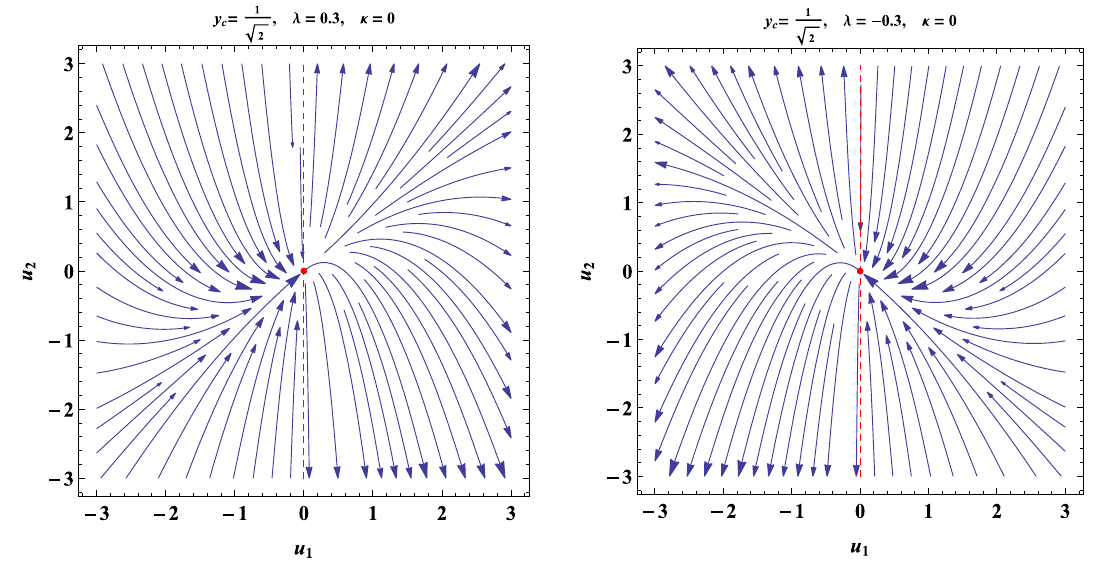
Fig. 4 Phase plot of system (53) for some values of the parameters showing that A (cid:4)